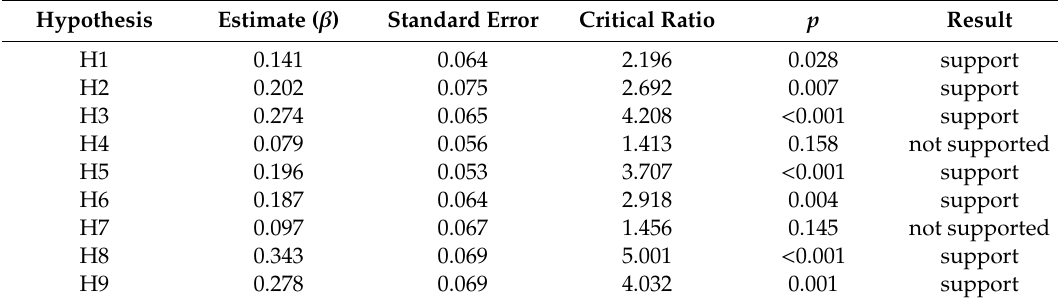
Table 5. Hypotheses and